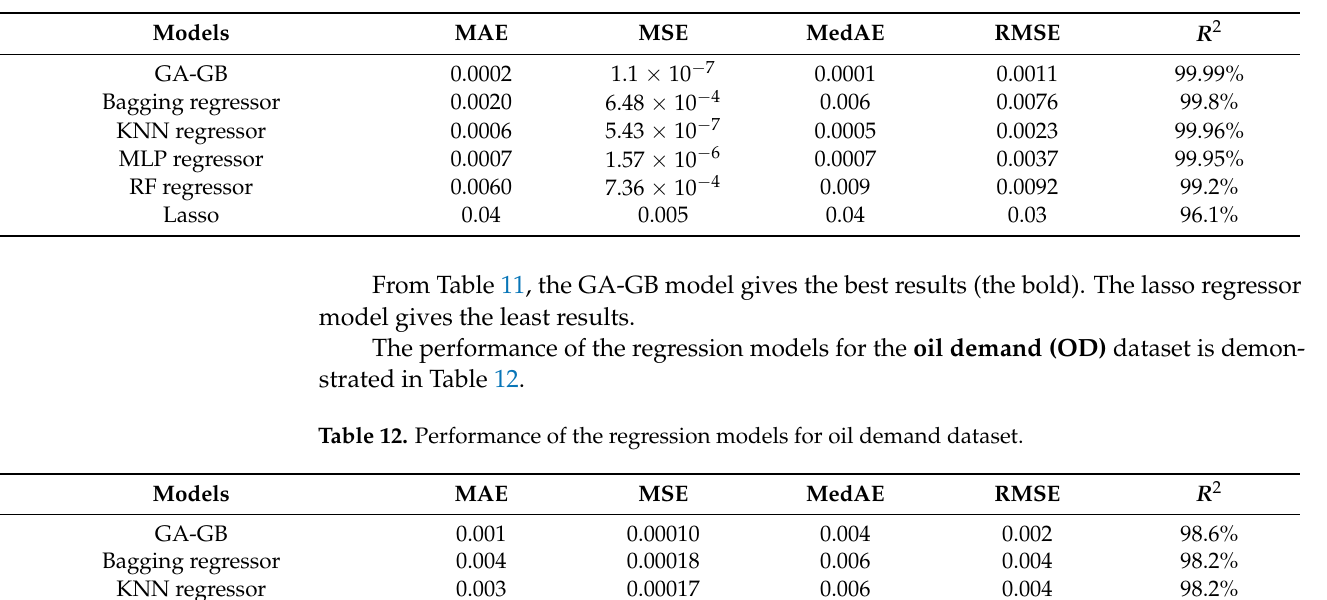
Table 11. Performance of the regression models for oil price dataset.